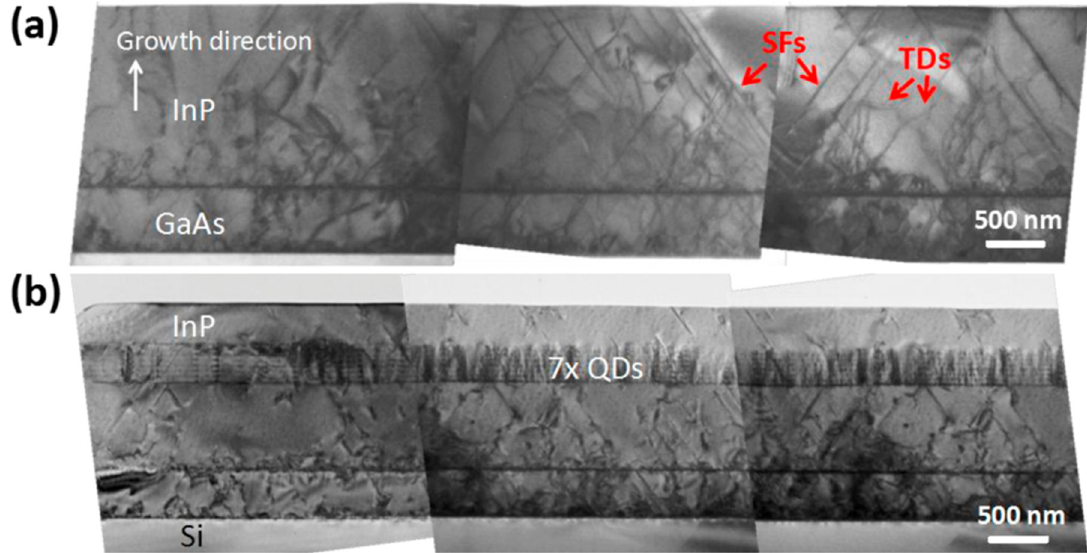
Figure 17. ( a ) Large-area cross-sectional TEM images of the InP-on-Si ( a ) without and ( b ) with QD DFLs. Reprinted with permission from Reference [232] © 2016 Elsevier B.V.